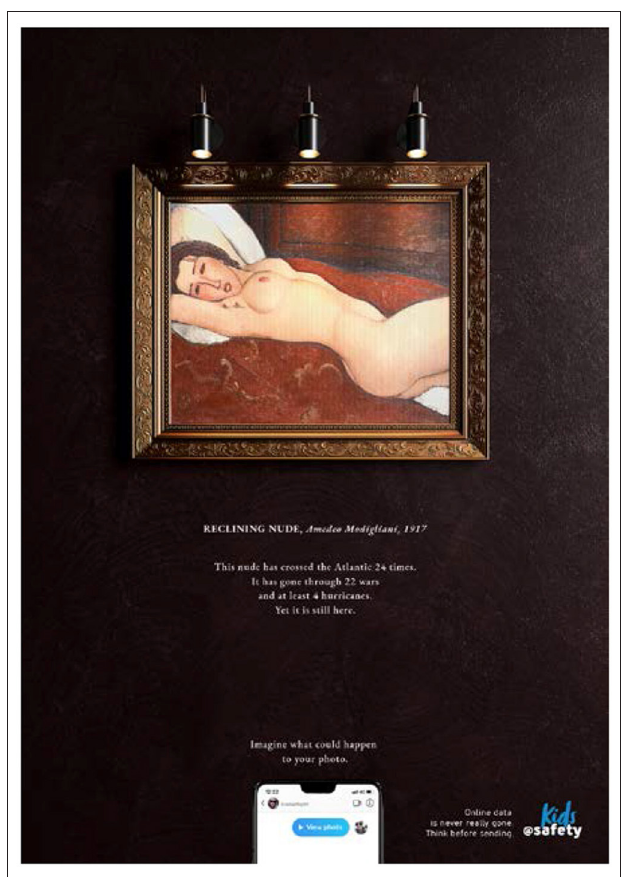
FIGURE 4 | Example 2: Wind Telecom, The Newtons Laboratory, Athens, Lürzer’s Archive 3/2020: 130.